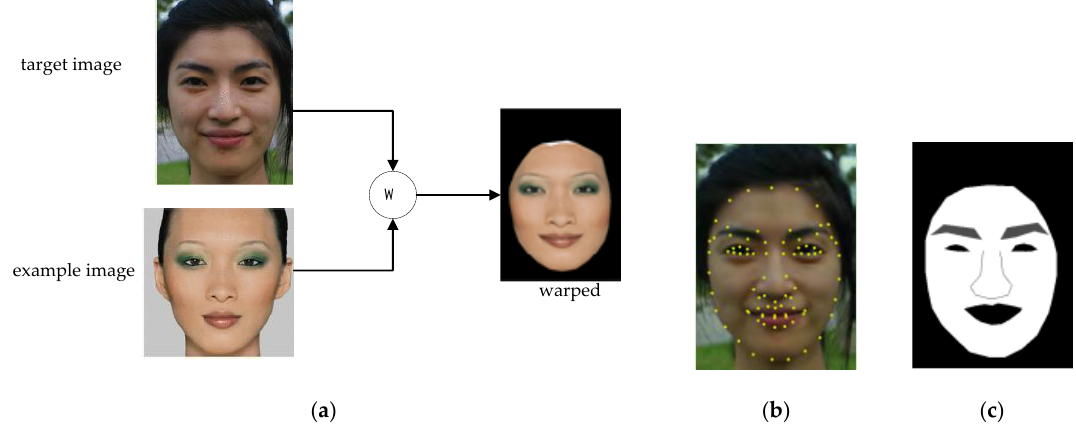
Figure 1. Face alignment. ( a ) Warping the example image to target image, W denotes warping ( b ) Facial feature points on a face ( c ) Facial components defined by facial feature points in ( b ).